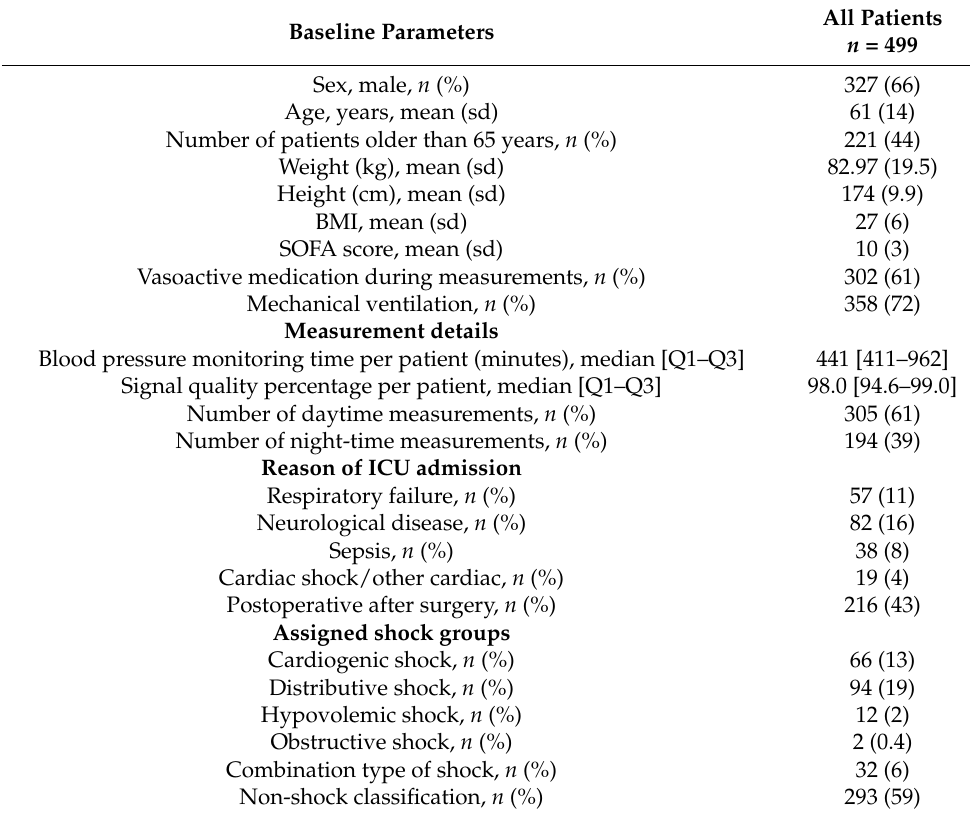
Table 1. Baseline